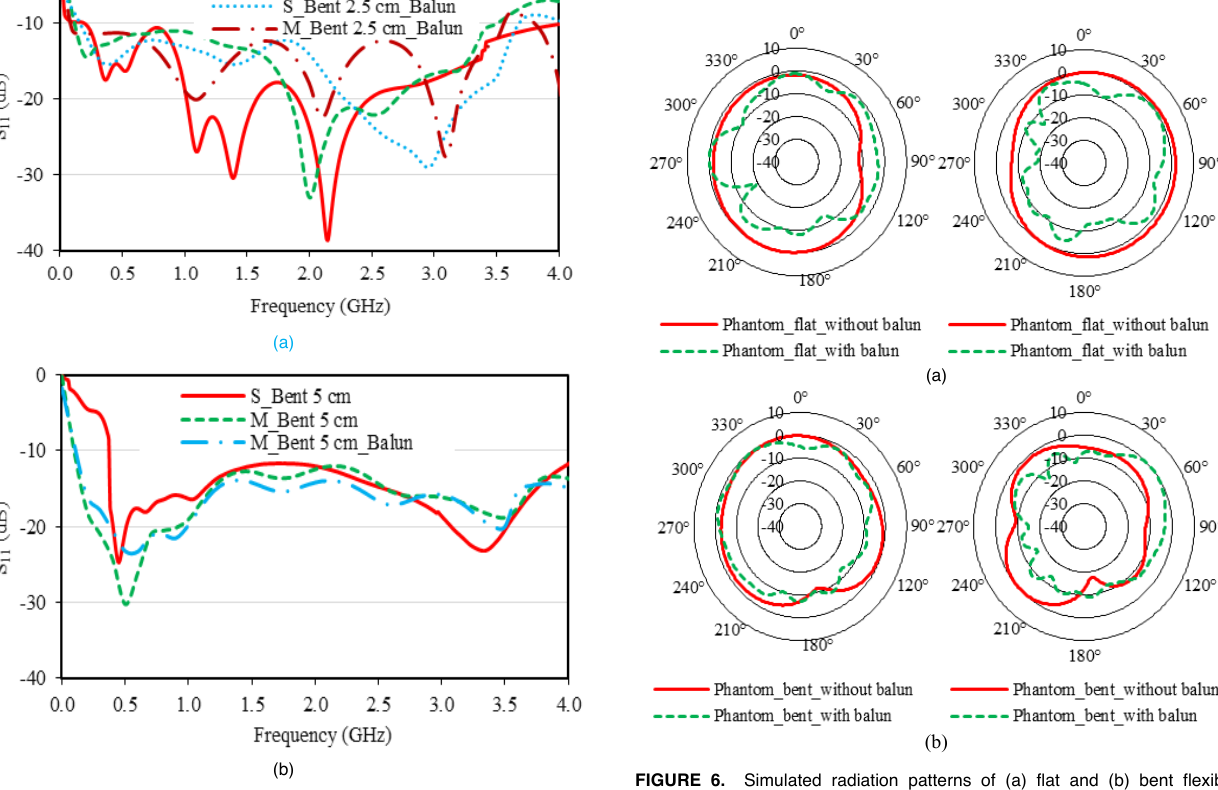
FIGURE 5. S 11 of bent flexible antenna implanted in muscle phantom at (a) 2.5 cm and (b) 5 cm depths based on simulation (S) and measurement (M) results.